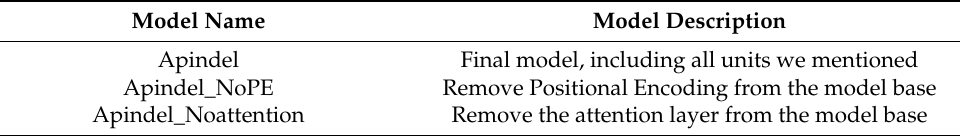
Table 2. Initial selection of the model-network framework.